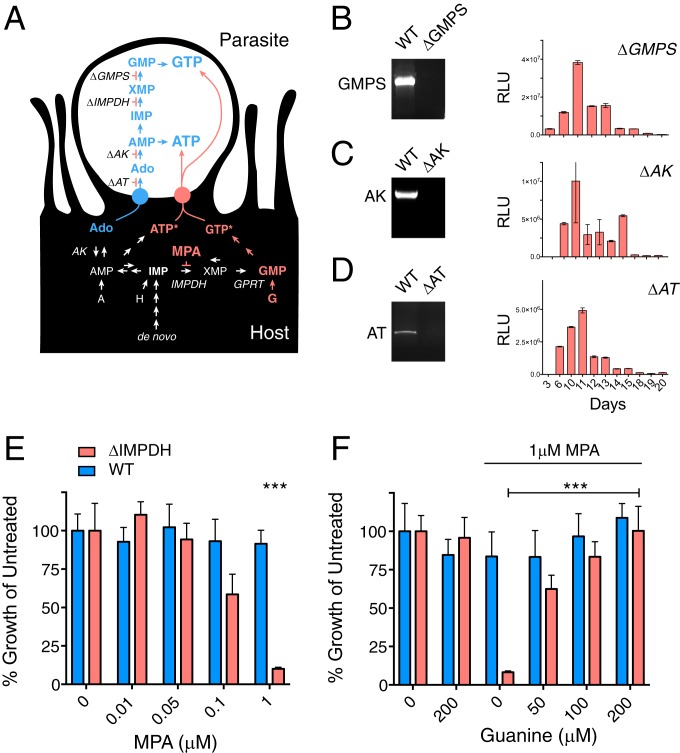
C. parvum tolerates loss of purine synthesis, which renders it dependent on host-derived purine nucleotides. (A) Simplified schematic representation of human host and C. parvum parasite purine metabolism. The parasite purine salvage pathway is shown in blue; the enzymes and transporter ablated in this study are indicated. The proposed parasite nucleotide uptake pathway is highlighted in red. The host can synthesize purines de novo or salvage different bases and nucleosides. Mycophenolic acid (MPA) blocks all routes to GMP except guanine phosphoribosyltransferase (GPRT). A, adenine; Ado, adenosine; G, guanine; H, hypoxanthine. *Note that it is yet unknown whether the presumptive nucleotide transporter imports tri- (as shown here), di-, monophosphates, or all of them. (B–D) GMPS, AK, and AT can be ablated. PCR of WT and respective mutant strains demonstrating loss of coding sequence. Please refer to SI Appendix, Figs. S2–S4 for full details on the validation of these 3 deletion mutants including mapping controls and whole-genome sequencing. NanoLuciferase measurements (reported as relative luminescence units; RLUs) from mouse feces showing that all strains are viable and readily infect mice. Samples were pooled from 4 to 6 mice in triplicate; error bars are SD; representative graph from 1 of 3 biological repeats. (E) C. parvum WT and ΔIMPDH parasites were cocultured with human host cells and subjected to MPA treatment over a range of concentrations (growth was measured by luciferase assay). Note the hypersensitivity of ΔIMPDH at 1 µM (***P < 0.001). (F) Growth of ΔIMPDH treated with MPA is rescued by addition of guanine to the medium (***P < 0.001). (E and F) Unpaired, 2-tailed t test with Welch’s correction. n = 6; 1 of 3 biological repeats is shown; error bars are SD.